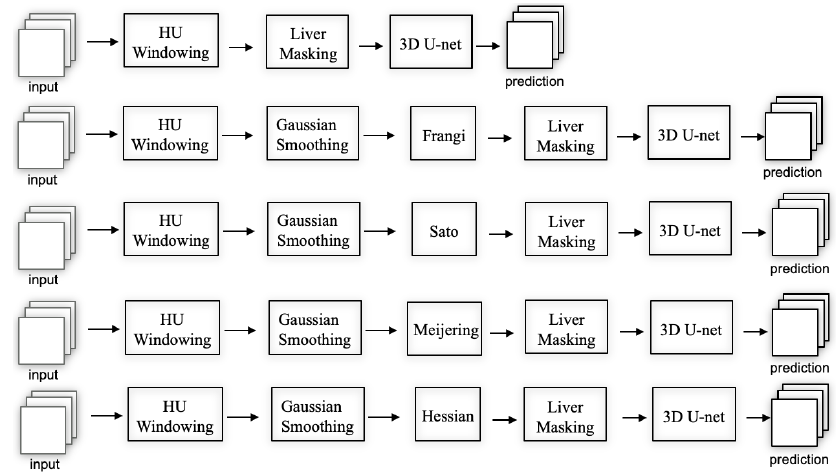
Figure 3. Workflow of the unenhanced and different vesselness enhancement approaches.